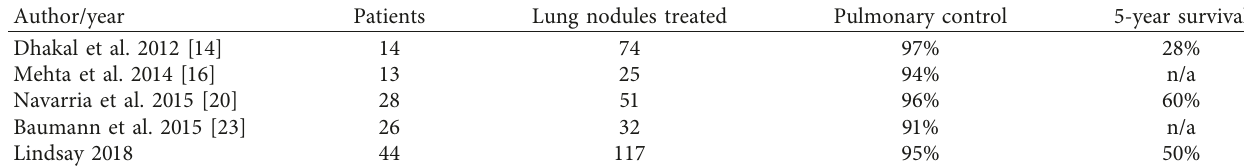
Table 5: Published series using SBRT for sarcoma lung